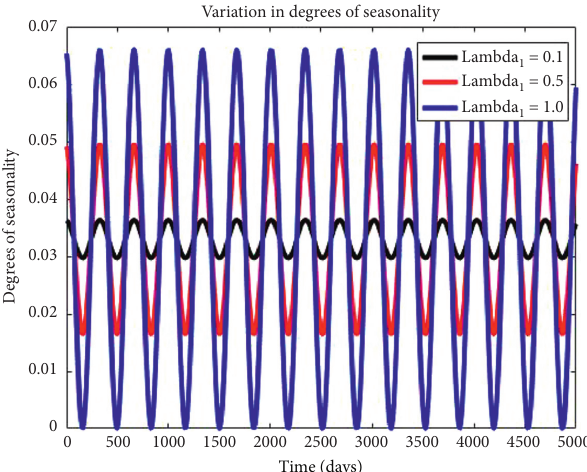
Figure 4: Variation in the degrees of seasonality, we varied dif- such ferent values of Λ 1